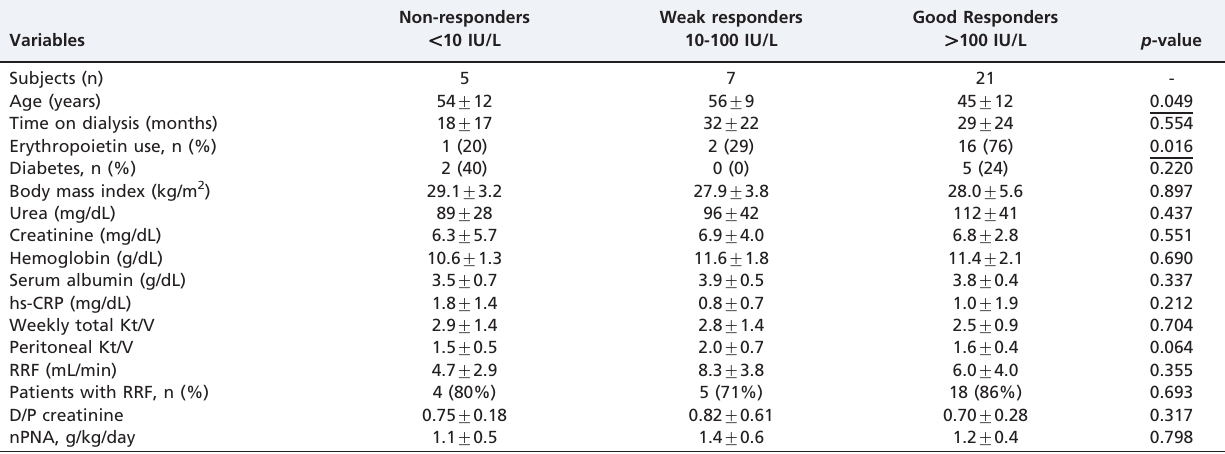
Table 3 - Responses to four-dose HBV vaccination schedule measured by anti-HBs titers and clinical, laboratory, dialysis adequacy, and residual renal function values in 33 peritoneal dialysis patients. Values are expressed as the mean ¡ SD, unless otherwise noted. Statistically significant values are